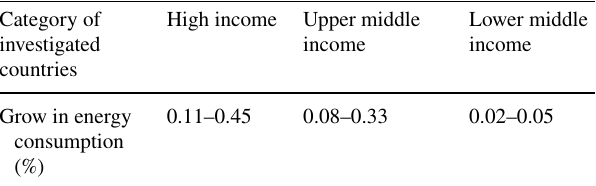
Table 5 Energy consumption with respect to income of